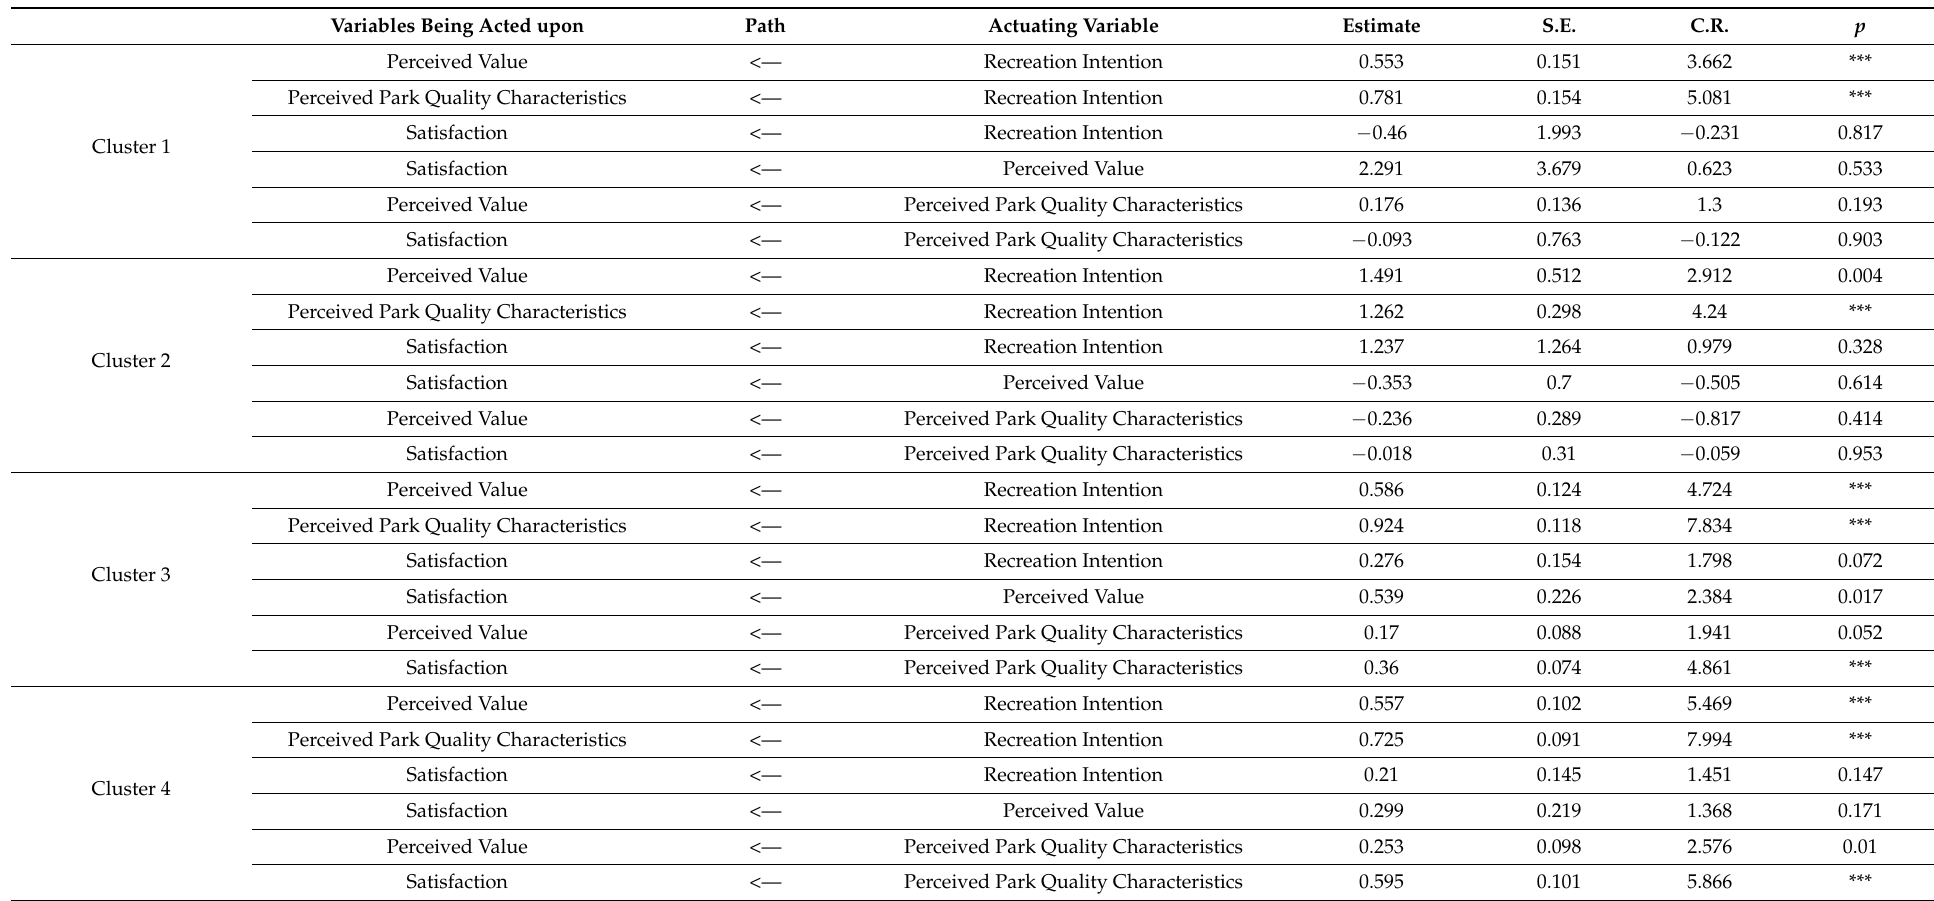
Table 7. Significance analysis of each variable in four